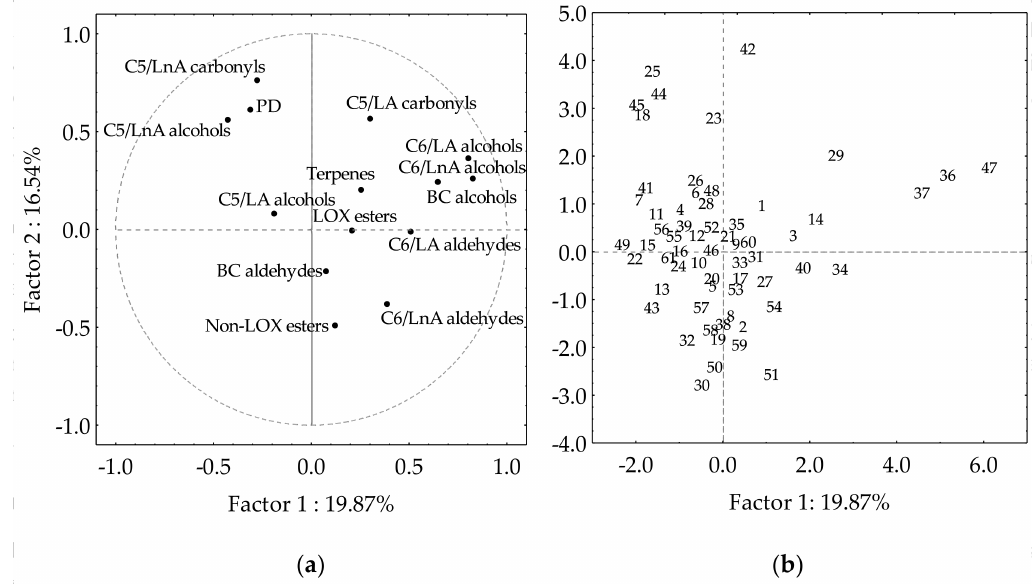
Figure 3. Main groups of volatile compounds in the oils from the WOGC cultivar subset. ( a ) Vector distribution of the volatile groups. ( b ) Distribution of the